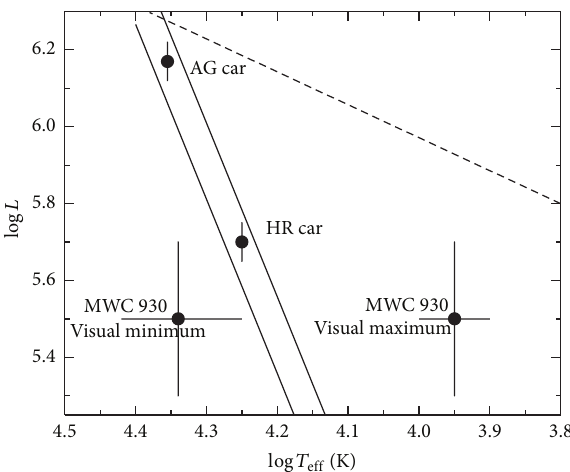
Figure7:AHertzsprung-RusselldiagramwithpositionsofsomeLBVs.Thesolidlinesshowtheboundariesofthevisualminimumbrightness instability strip for LBVs at which the stellar rotation velocity equals the breakup velocity [8]. The dashed line represents the Humphreys- Davidson stability limit [1]. Fundamental parameters of AG Car and HR Car at a visual minimum are taken from [8]. Luminosity is plotted in the solar units and temperature in